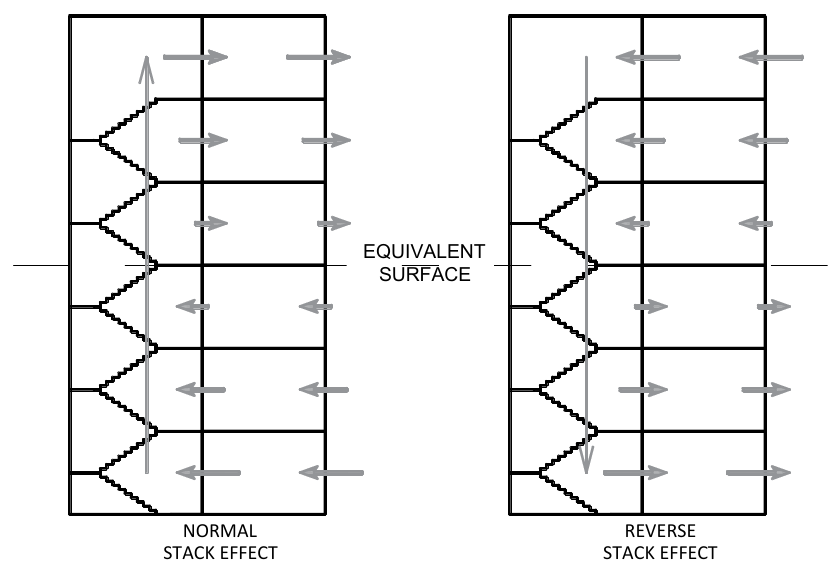
Figure 2. Normal and reverse stack effects.